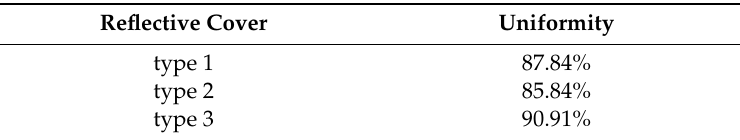
Figure 9. Simulation results of each reflective cover type: ( a ) Results of the reflective cover type 1, ( b ) Results of the reflective cover type 2, ( c ) Results of the reflective cover type 3. Table 5. Uniformity of reflective cover type simulation results.